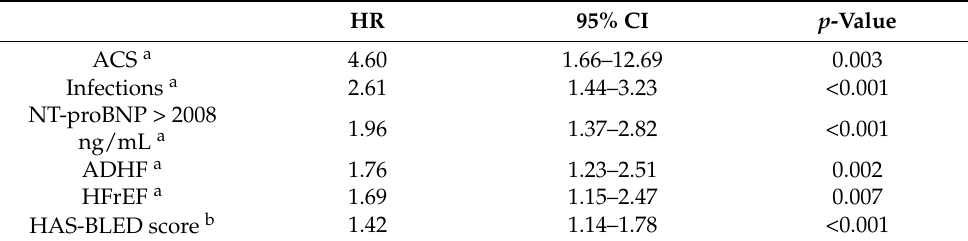
Table 4. Determinants of prolonged LOS—multivariable